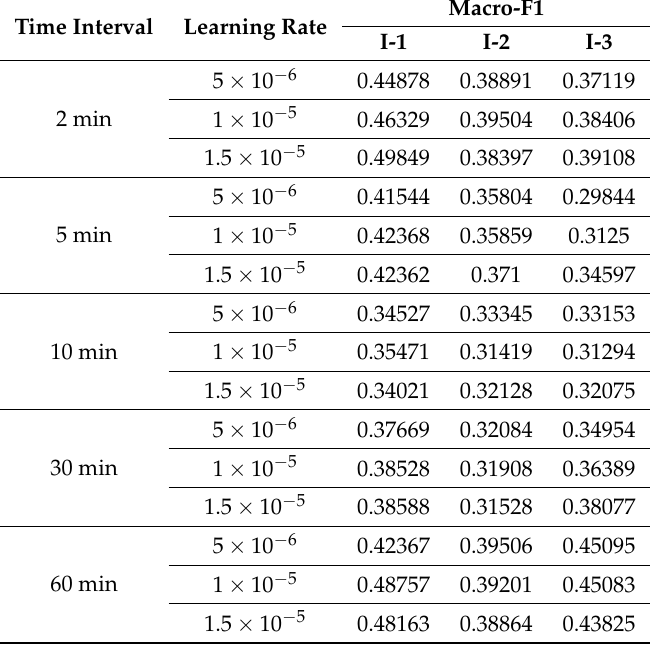
Mean macro averaged F1 testing results of all events that are obtained using leave-one-event-out cross-validation along T by varying learning